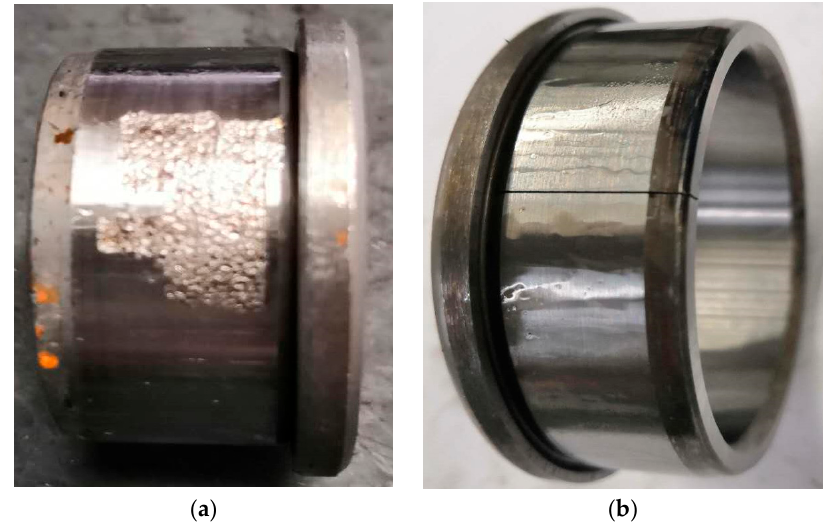
Figure 13. Faulty bearing. ( a ) NJ405 bearing. ( b ) NJ210 bearing.